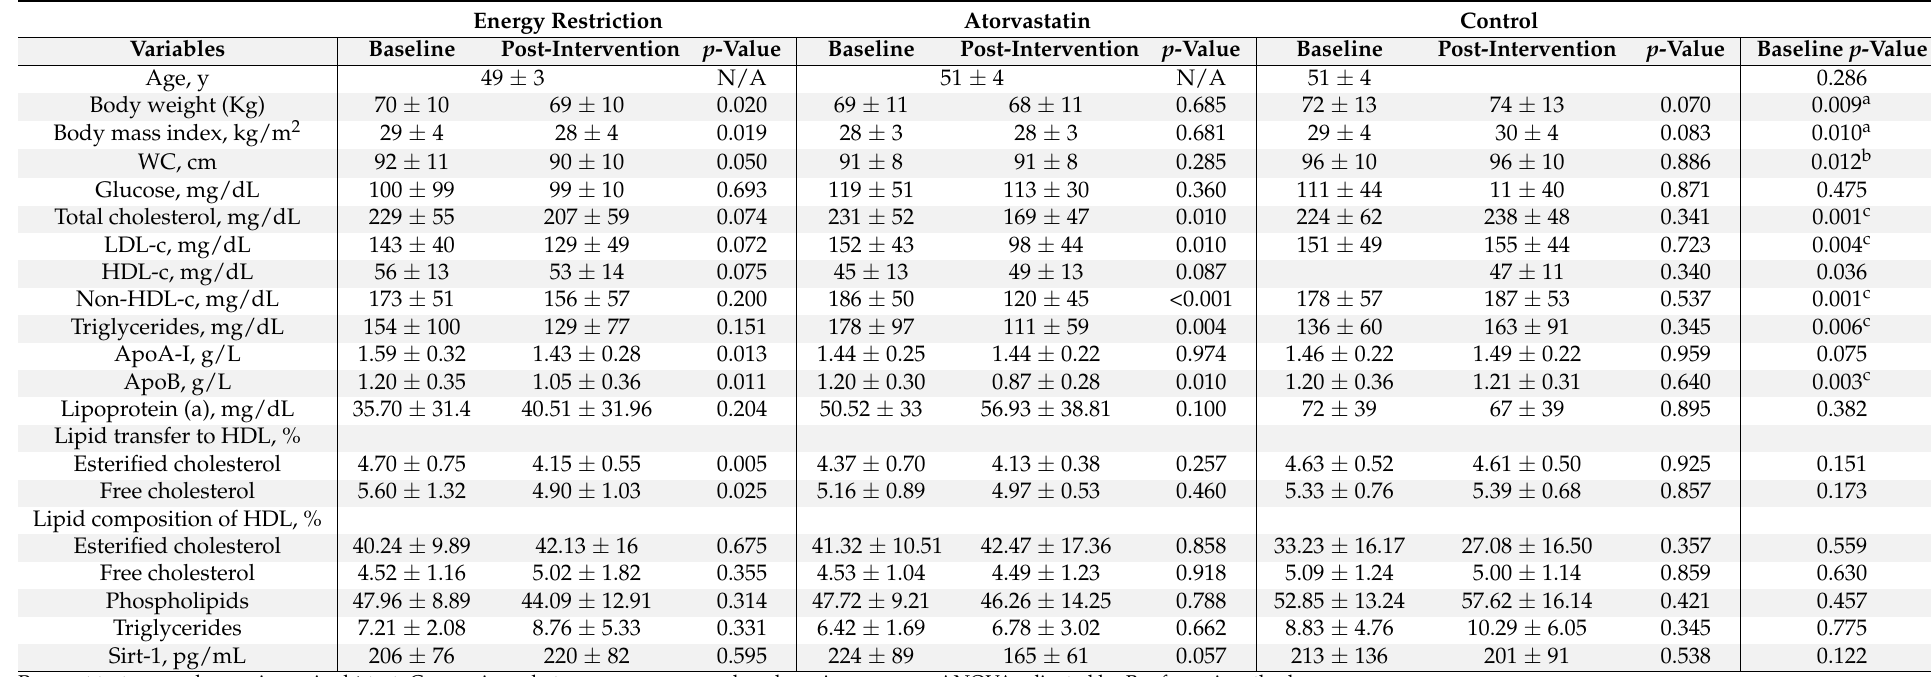
Table 1. Baseline and post-intervention characteristics of the